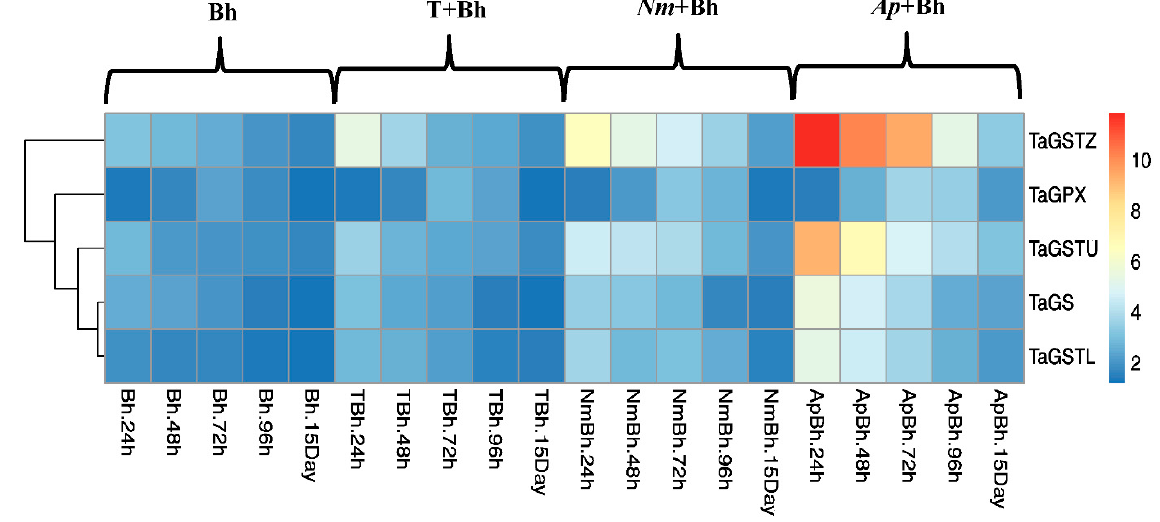
Figure 5. A heatmap showing the effect of Bh application alone or in combination with different safener treatments on wheat plants at the vegetation stage on the relative expression of wheat detoxification-related genes. The transcript abundance level is shown in the color legend, where red specifies the transcripts with a higher level, and blue specifies transcripts with a lower level. Bh: bromoxynil; T + Bh: tryptophan + bromoxynil; Nm + Bh: Nostoc muscorum + bromoxynil; Ap + Bh: Arthrospia platensis + bromoxynil.